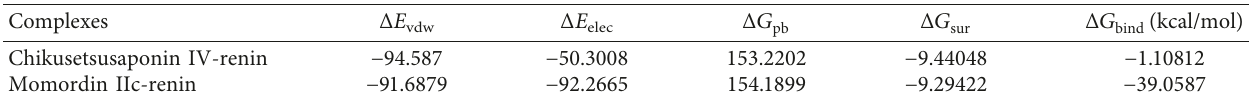
Table 5: Free binding energies of the